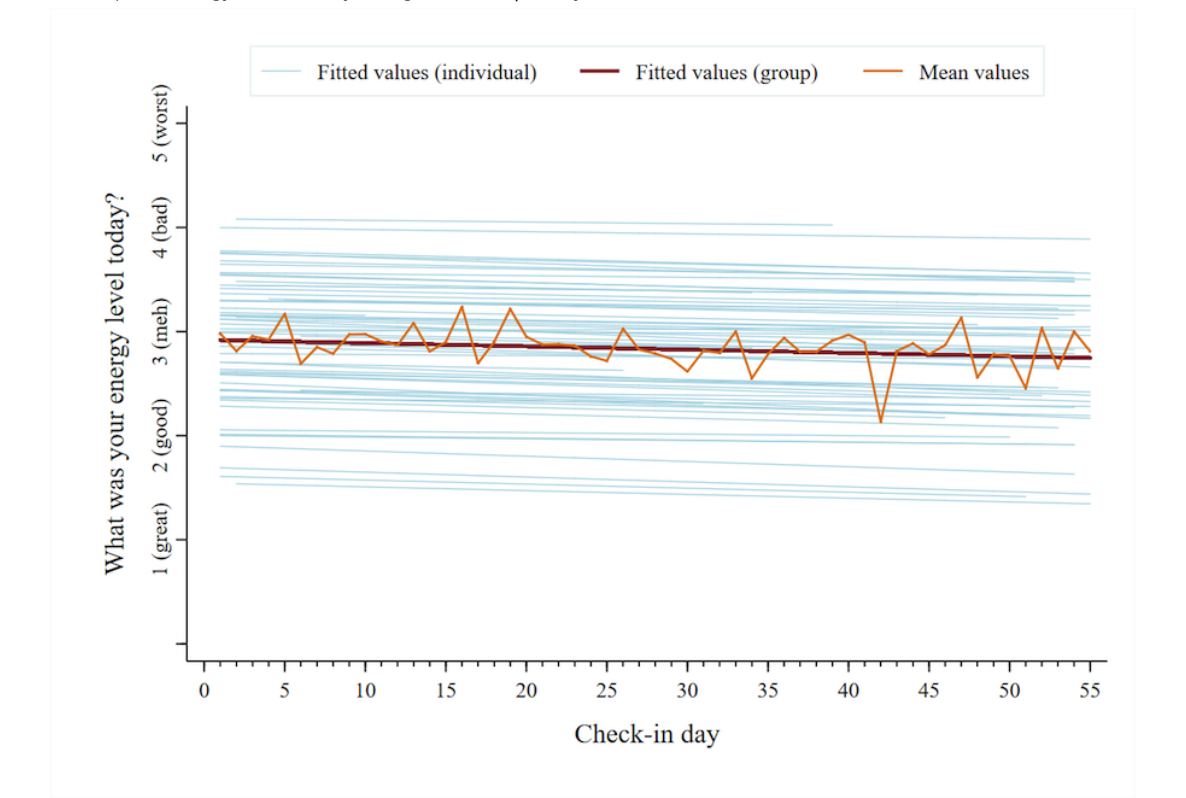
Figure 10. Self-reported energy across 55 days using the iCanCope daily